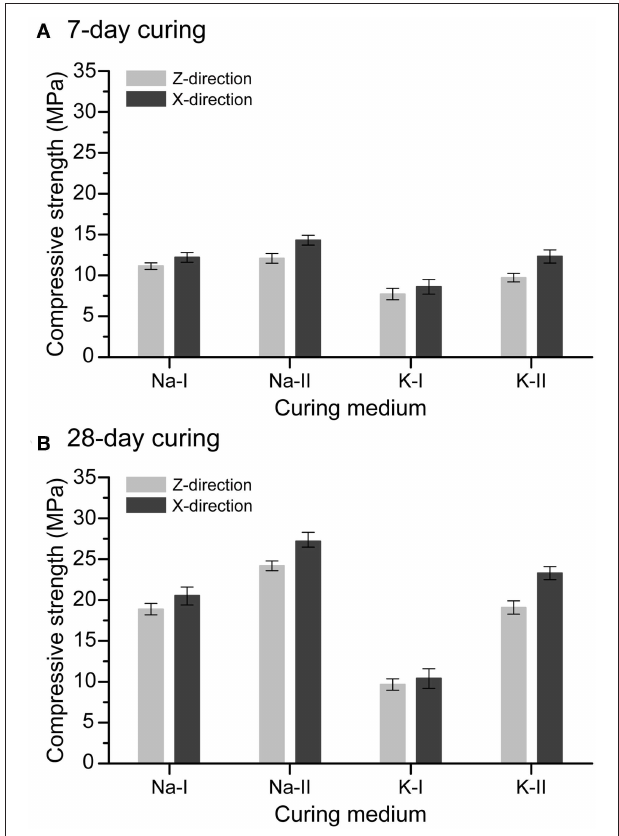
FIGURE 6 | Compressive strength of the ambient temperature cured 3D printed geopolymers at (A) 7 days and (B) 28 days. The error bars are calculated by standard deviation.